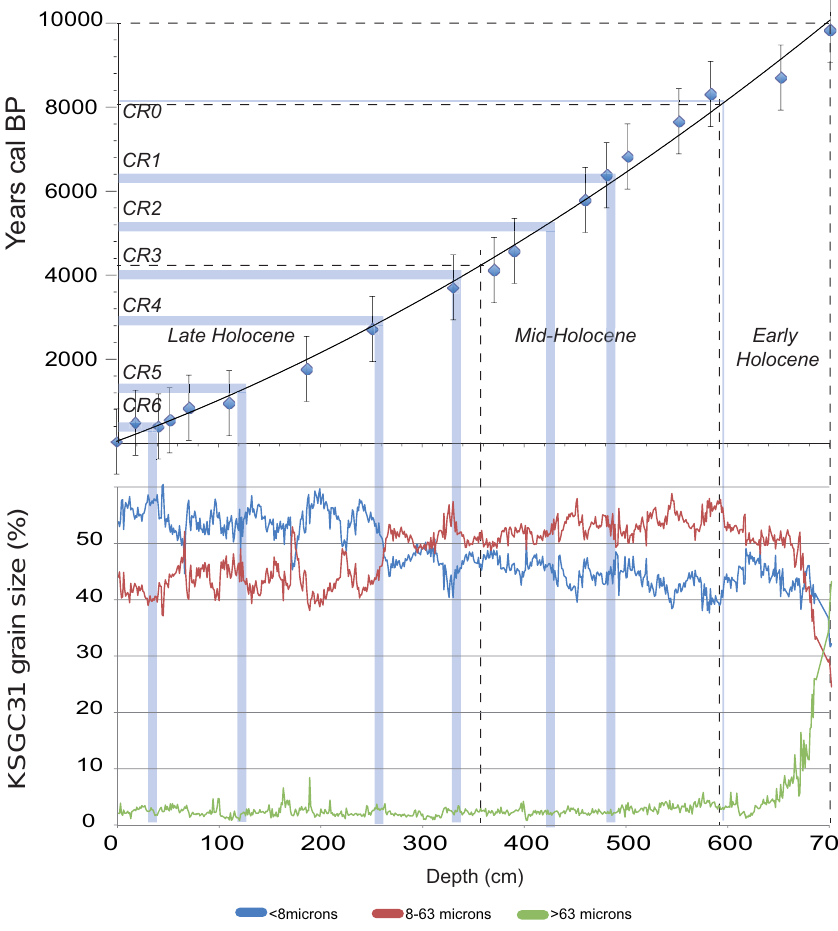
Figure 3. Correlation age–depth in core KSGC31. The Holocene time is divided into early, middle and late Holocene according to Walker et al. (2012). General core lithology is shown through the distribution of three grain size classes: <8, 8–63 and